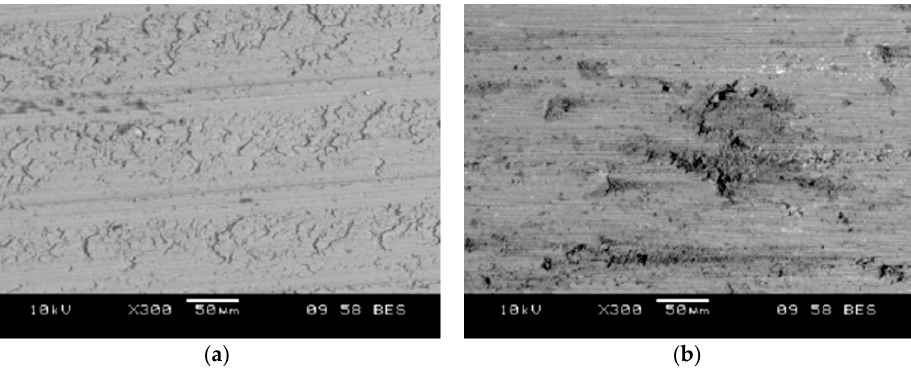
Figure 14. SEM image of surface after machining with DCMW PCD tool: ( a ) AlSi7Mg2Sr003 base alloy; ( b ) AlSi7Mg2Sr0.03/SiC p 10 vol % composite.